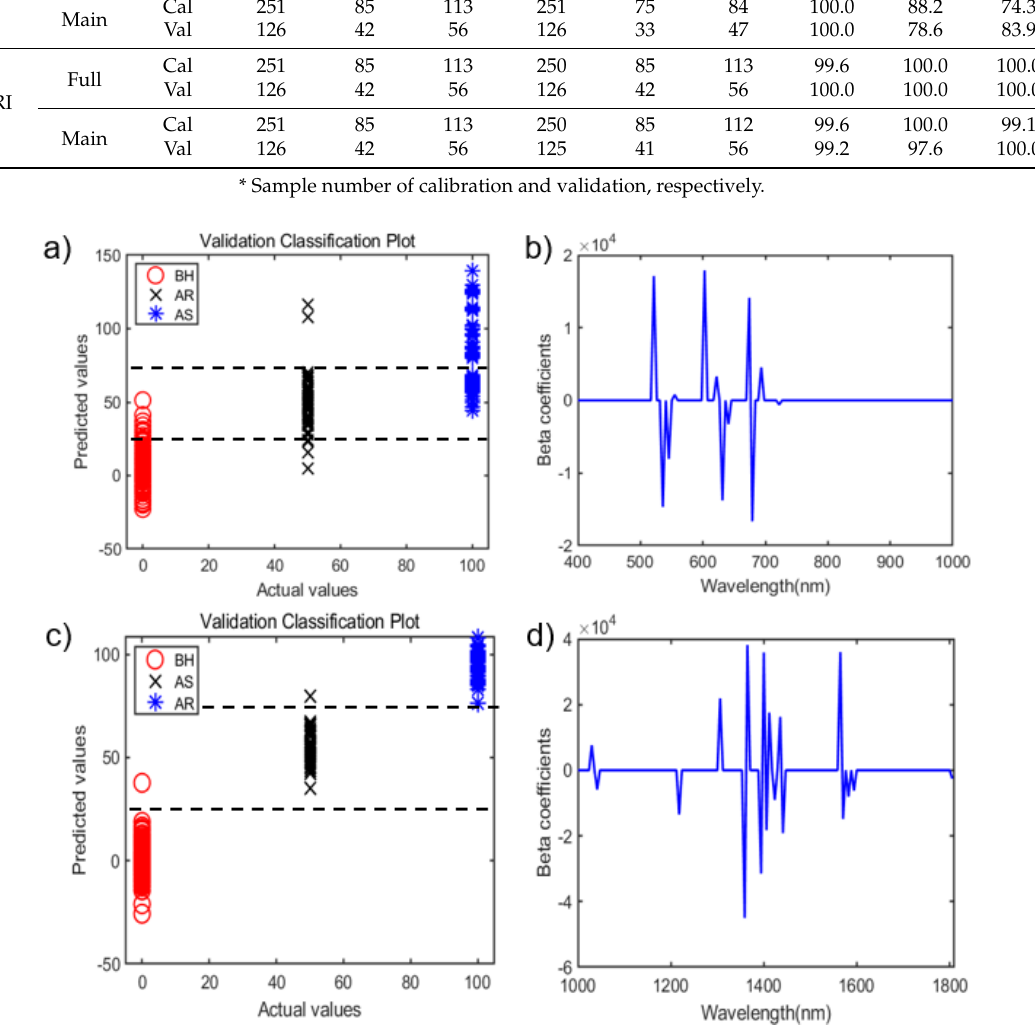
Figure 5. SPRI value of PLS-DA results of the 12 bands of spectra in Vis/NIR and of 18 bands of spectra in SWIR. ( a ) Classification plot of validation in Vis/NIR. ( b ) Beta coefficients of PLS-DA in Vis/NIR. ( c ) Classification plot of validation in SWIR. ( d ) Beta coefficients of PLS-DA in SWIR.